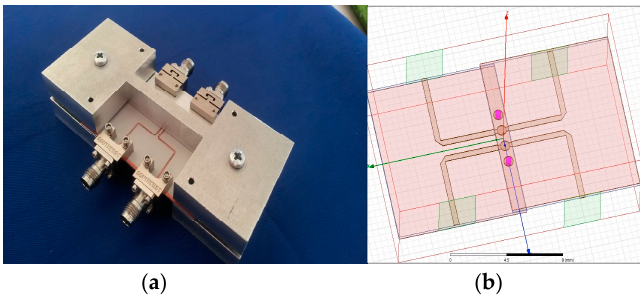
Figure 20. ( a ) Planar transmission line contact assembly with parallel microstrip lines; ( b ) ACP between the overlap region for complete field penetration.